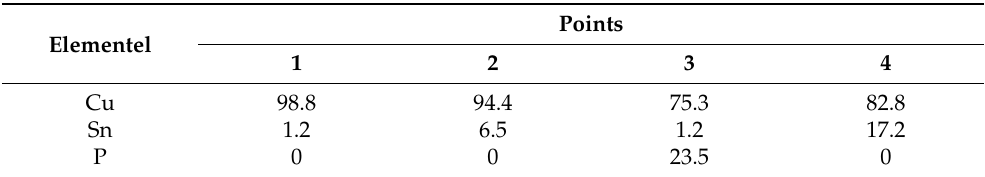
Figure 2. Initial semi-solid CuSn10P1 alloy blanks: ( a ) SEM image, ( b ) local magnification, ( c ) Figure 2 ( b ) Sn element distribution, ( d ) Figure 2 ( b ) P element distribution, ( e ) Figure 2 ( b ) Cu element distribution (arrows indicate high Sn solid solution circle regions). Table 1. Test results of the energy dispersive spectroscopy (EDS) points at different positions of semi-solid CuSn10P1 alloys (at.%).